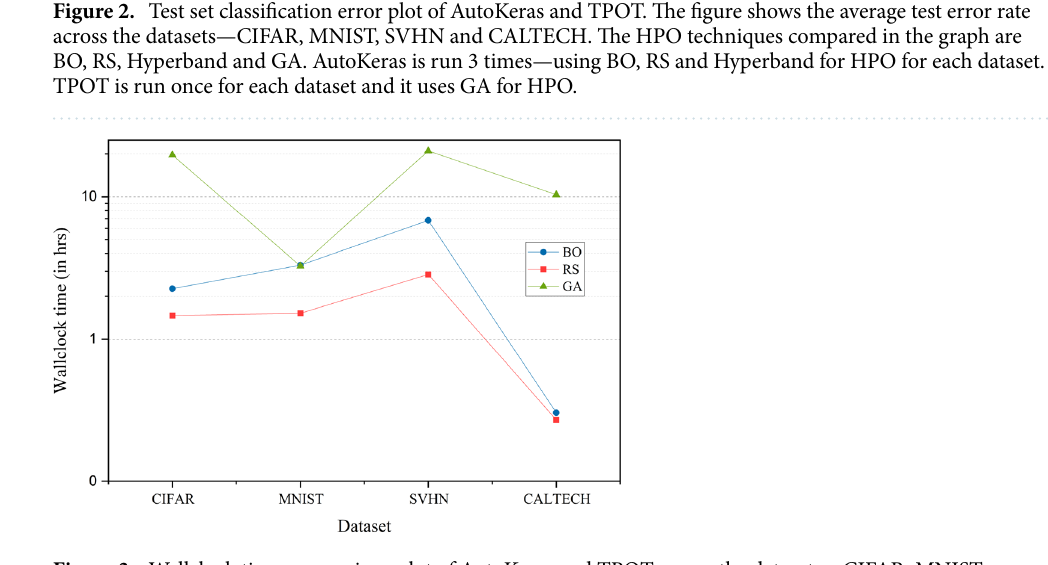
Figure 3. Wallclock time comparison plot of AutoKeras and TPOT across the datasets—CIFAR, MNIST, SVHN and CALTECH. The HPO techniques compared in the graph are BO, RS, Hyperband and GA. AutoKeras is run 3 times—using BO, RS and Hyperband for HPO for each dataset. TPOT is run once for each dataset and it uses GA for